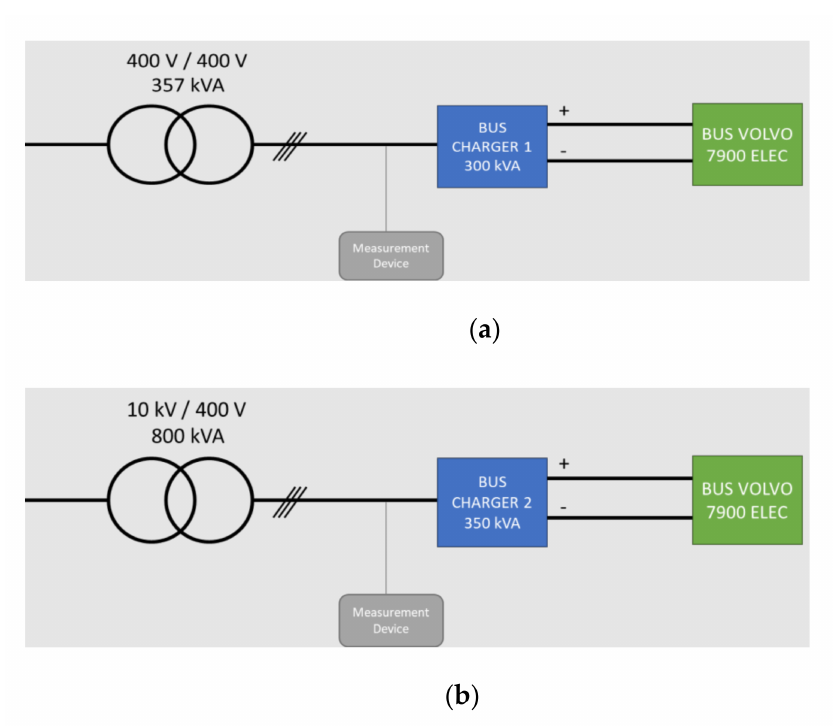
Figure 2. Measurement setup. ( a ) Charger 1; and ( b ) charger